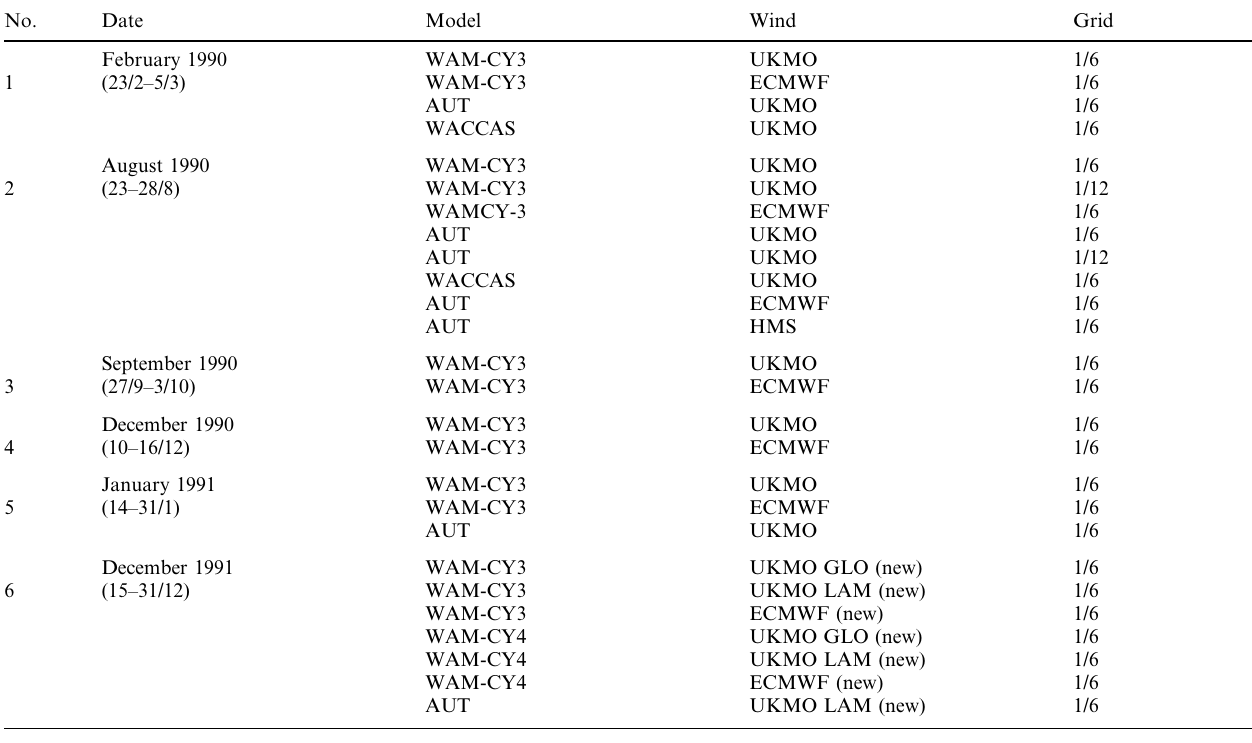
Table 2. The 26 implemented runs for the intercomparison study in Aegean Sea No.